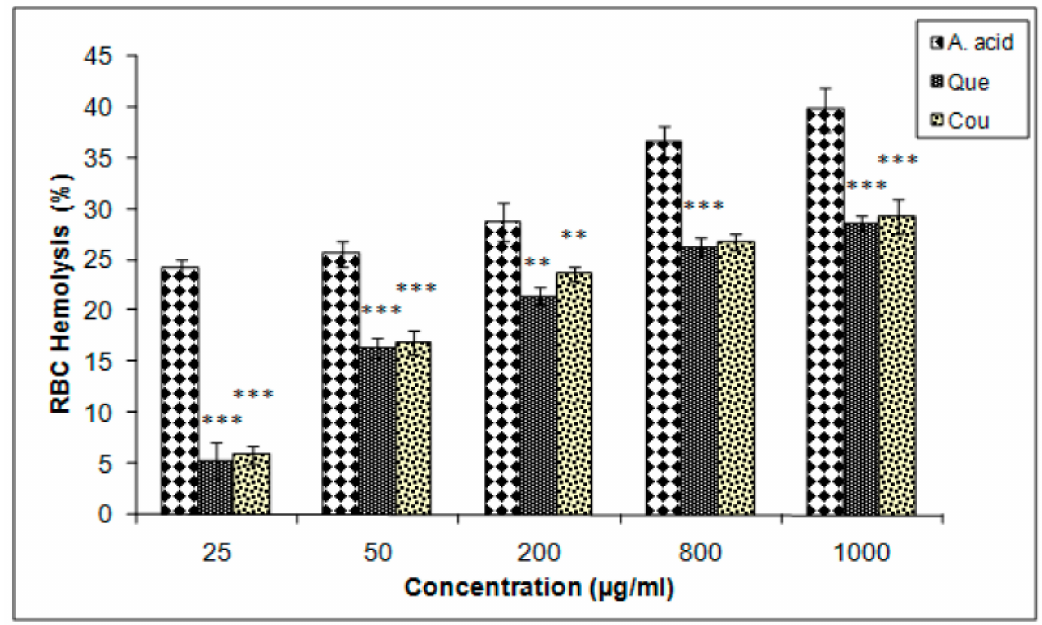
Figure 7. Erythrocyte haemolysis inhibition e ffi cacies of quercetin and coumarin as compared to the control; ascorbic acid. Each vertical bar represents the mean ± S.E.M. (n = 3). *** p < 0.001, ** p < 0.01 and * p < 0.05 as compared to the respective control values. A. acid, ascorbic acid; Que, quercetin; Cou,